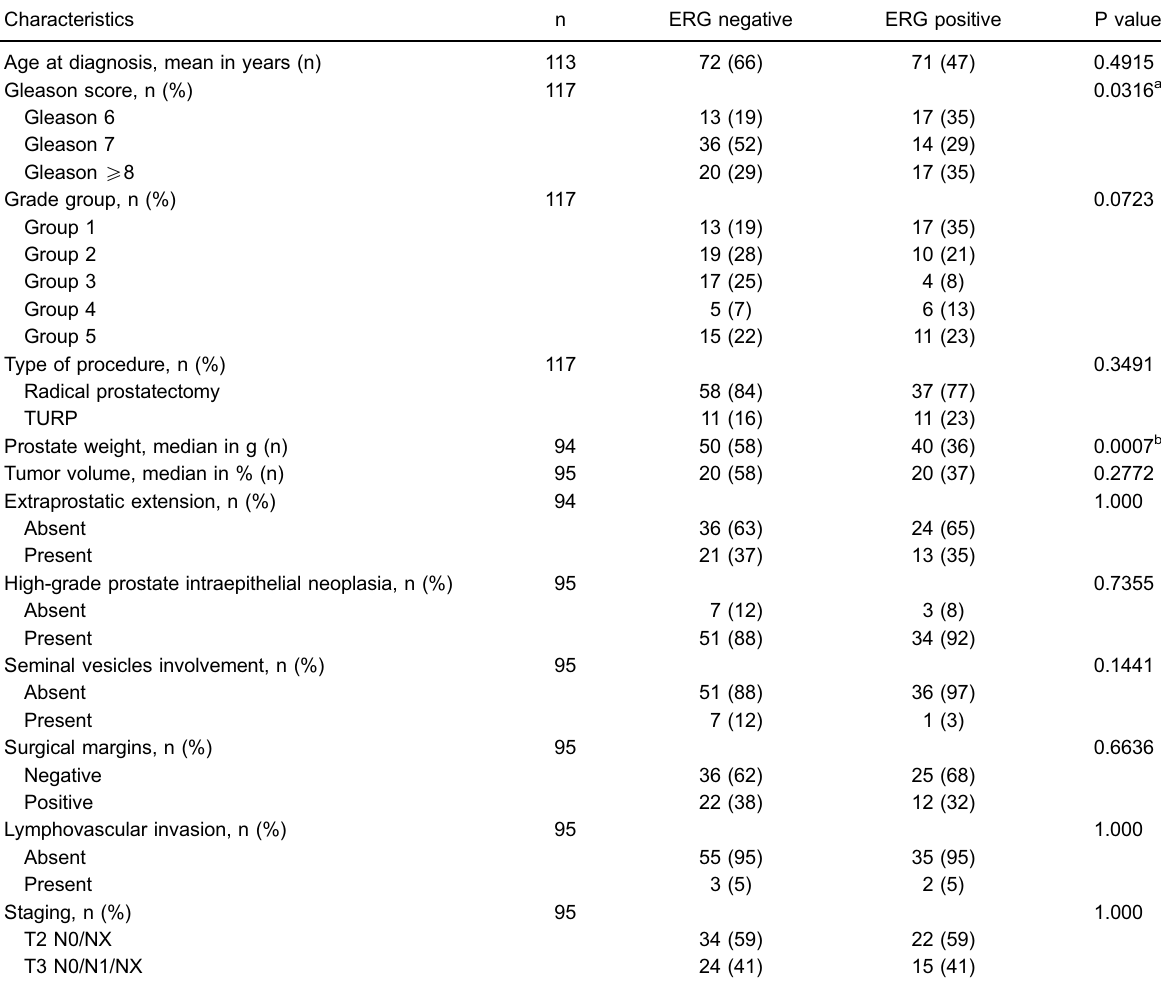
Table 2. Association of ETS-related gene (ERG) expression status and clinicopathological characteristics of men treated with radical prostatectomy or transurethral resection of the prostate (TURP) for prostate cancer.